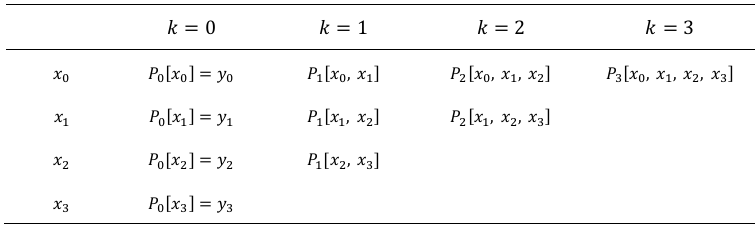
Table 2. Neville Method